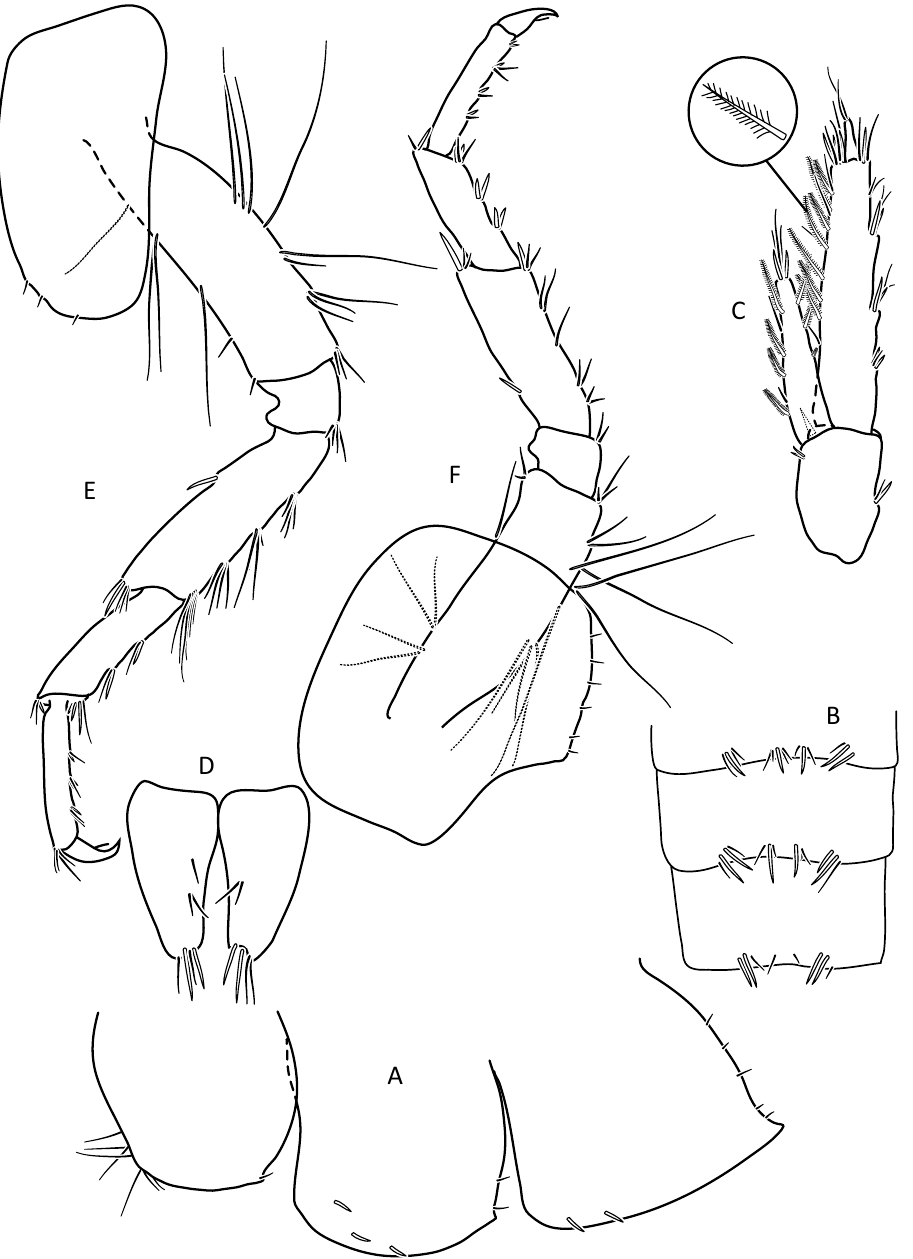
Figure 6. Gammarus stasiuki sp. nov., male—12 mm. ( a ) epimera I-III, ( b ) urosome, ( c ) uropod 3, ( d ) telson, ( e ) pereopod 3, ( f ) pereopod